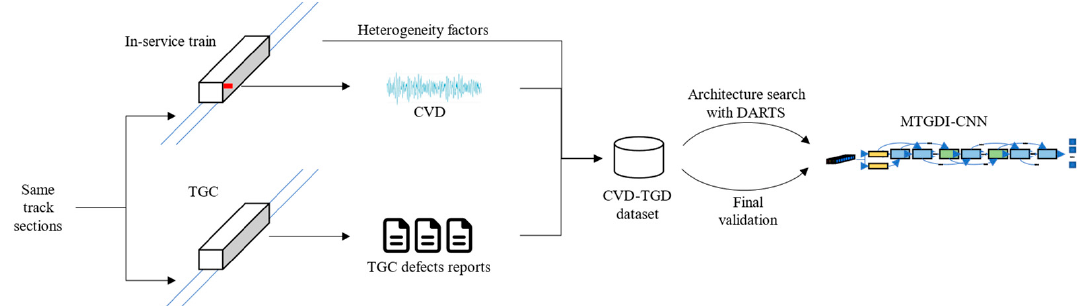
Figure 4. Framework of this study.